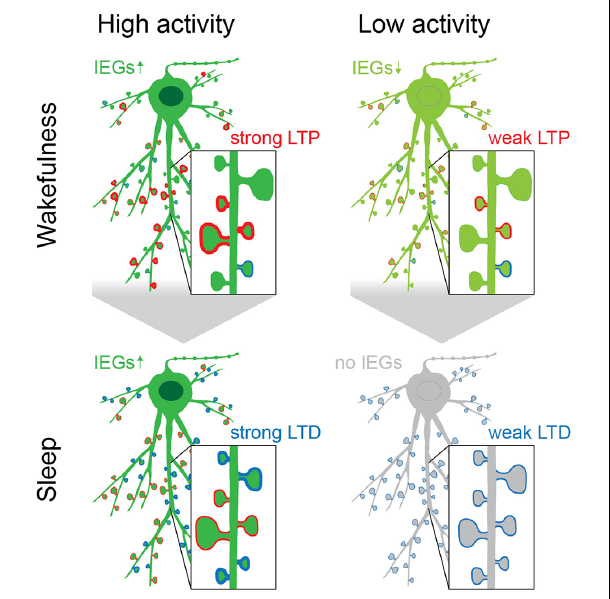
FIGURE 4 | The acquisition of new memories during wakefulness causes upregulation of IEGs (green), which is followed by a second rise of IEG expression during sleep, preferentially in neurons that were highly active, exhibit increased intrinsic excitability and are constituents of initial memory engrams. The upregulation of IEGs during sleep is initiated during REM, following replay during NREM, and causes homeostatic plasticity (i.e., downscaling) to reduce noise and interferences from “old” or redundant memory traces (spines with blue rim). Spines that are reactivated during replay may be strengthened and protected from downscaling (spines with red rim; Rosanova and Ulrich, 2005; Chauvette et al., 2012; Kruskal et al., 2013; Yang et al., 2014; Atherton et al., 2015; Li et al., 2017; Lisman et al., 2018). This may happen in a spine- or dendrite-specific manner, as it has been shown that during sleep dendritic segments experience Ca 2+ -spikes that are separate from the cell body, as well as dendrite specific plasticity (Yang et al., 2014; Kastellakis et al., 2015; Li et al., 2017; Seibt et al., 2017). While the effects of IEGs during sleep may be most specific to neurons that are part of newly formed engrams (dark green neurons), the kinases GSK3 β , Abl2, DCLK2, and CDK5 may act in concert to reduce synaptic strength on a global scale ( Table 1 , Diering et al., 2017; Bruning et al., 2019). Their combined action counterbalances the excess potentiation in the brain during wakefulness by “renormalizing” connections and thus aids the selective refinement of memory engrams (Cao et al., 2015; Attardo et al.,